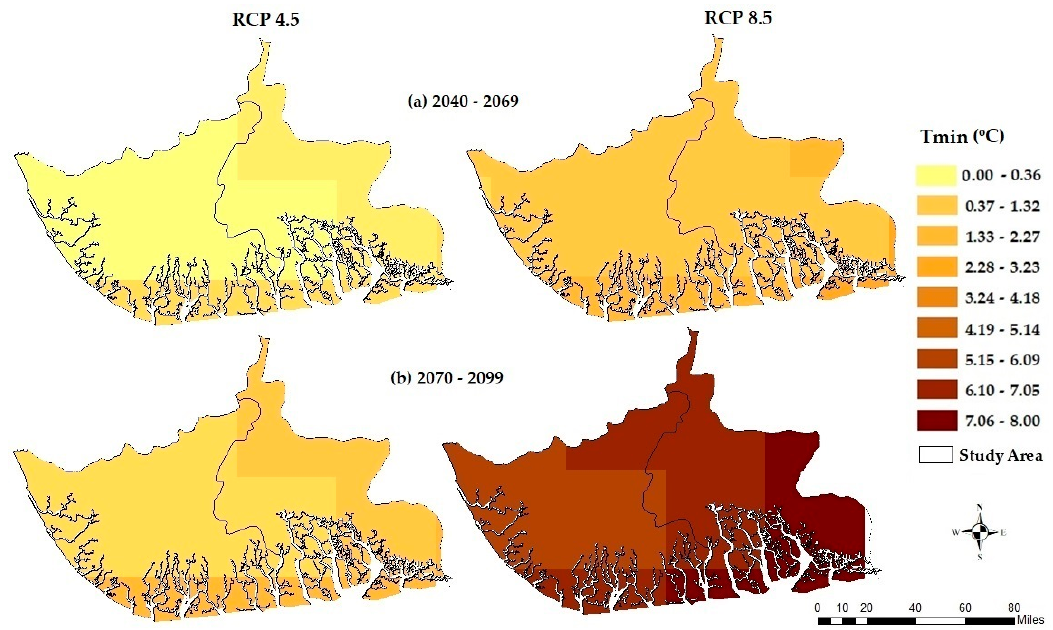
Figure 7. Spatial distribution of percentage changes in average annual maximum temperature for periods ( a ) 2040–2069 and ( b ) 2070–2099 compared to the base period 1980–2005 for RCP4.5 and RCP8.5.